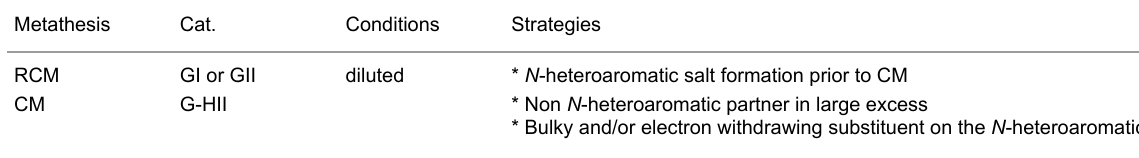
Table 5: Metathesis involving alkenes that contain N